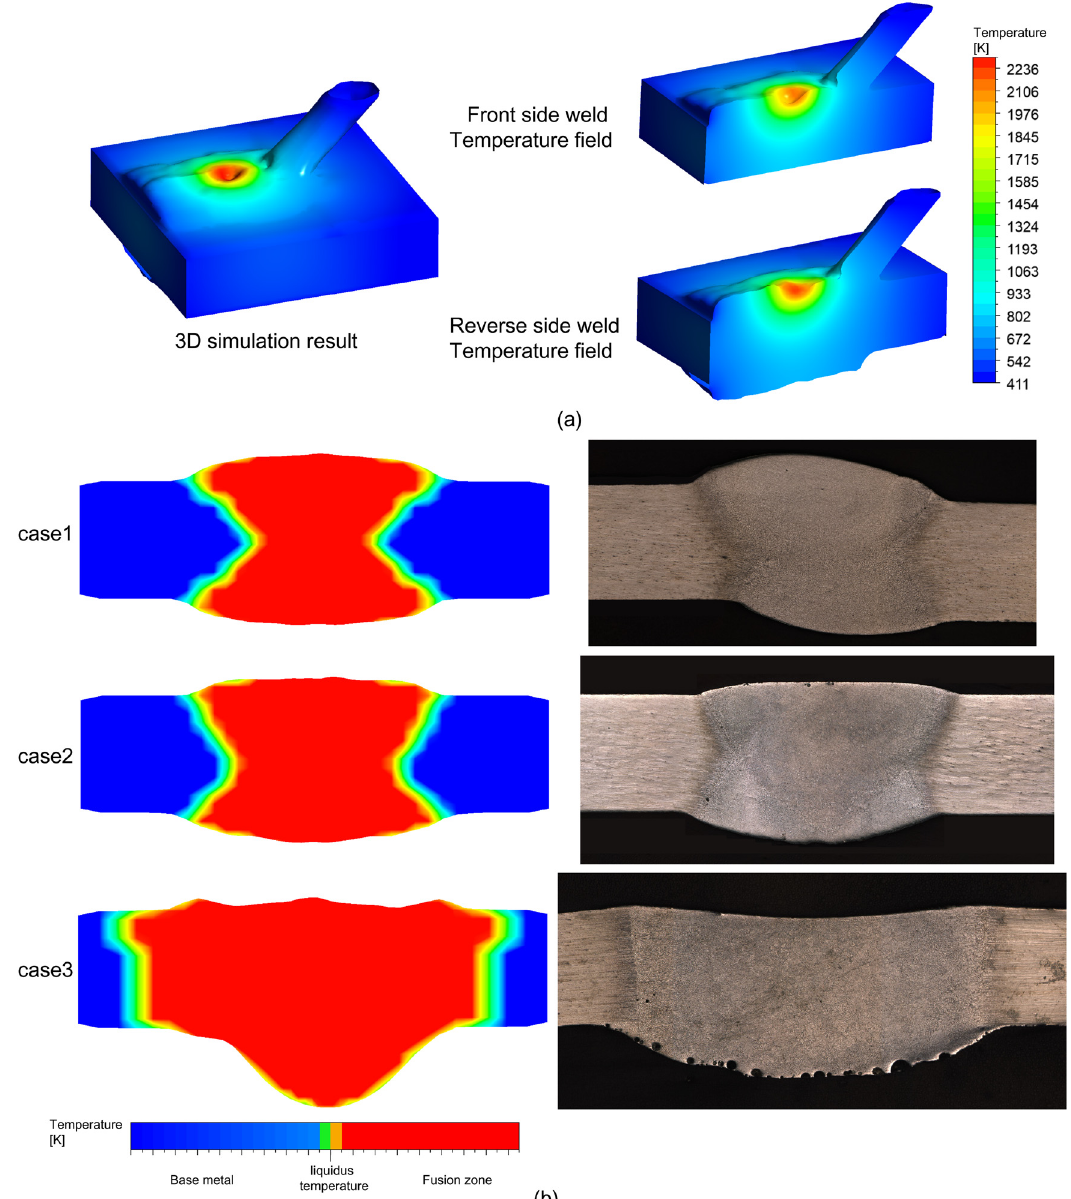
Figure 4: Experiment and simulation results. ( a ) Temperature fi eld in the weld; ( b ) the fusion zone of the simulation and the